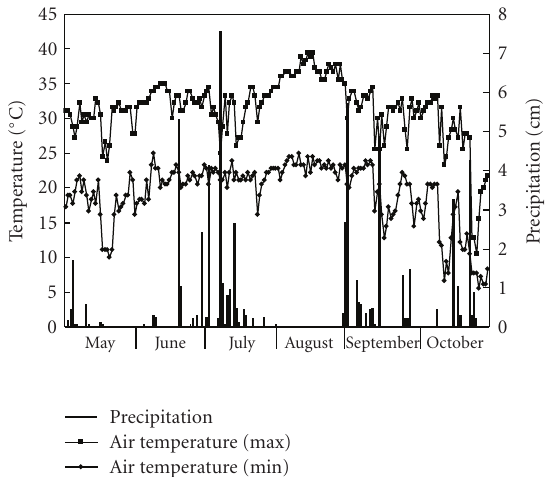
Figure 2: Air temperature and precipitation during the soybean growing season in 2007 at Stoneville, Miss, USA.